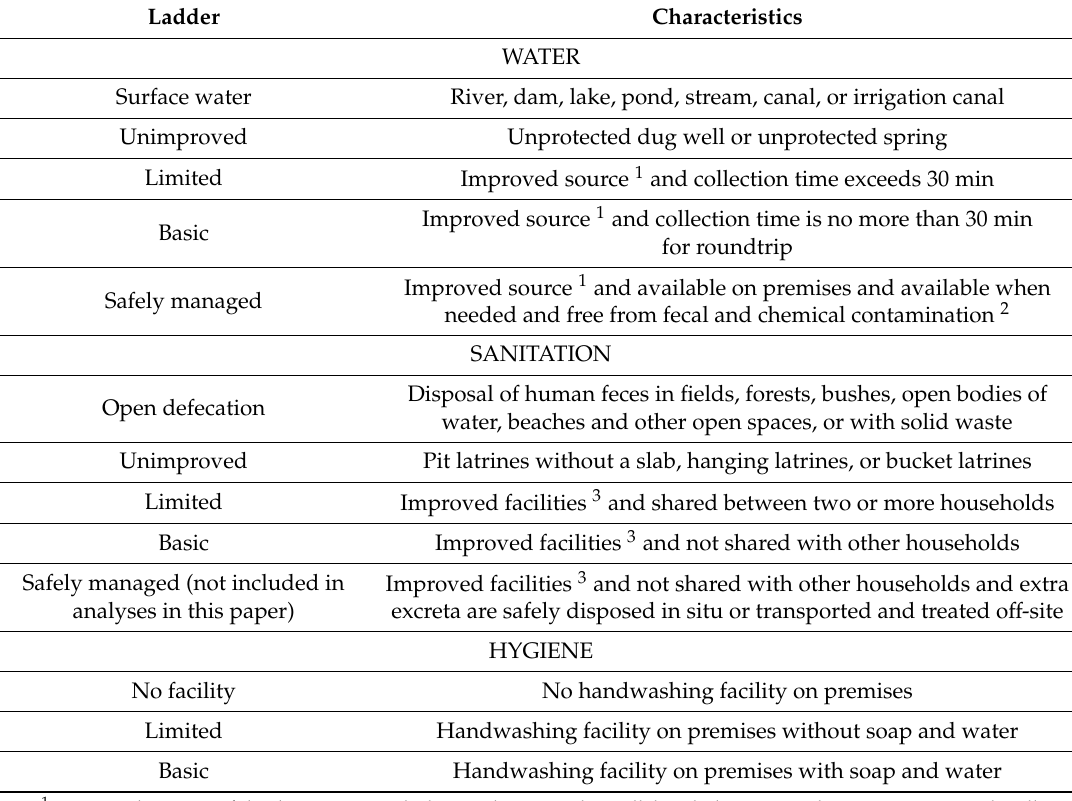
Table 2. WHO and UNICEF Joint Monitoring Programme for Water Supply, Sanitation and Hygiene (JMP) criteria